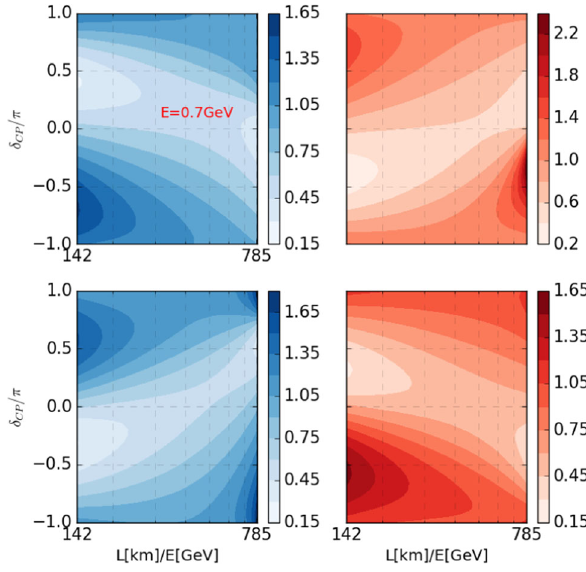
Fig. 3 Comparison between the unitary and non-unitary ν μ → ν e probabilities for φ 10 = π/ 2 ( − π/ 2) in the upper (lower) panel for the NO ν A experiment. Left (right) panel is for Normal hierarchy (inverted hierarchy). The unitary CP violating phase δ CP has been varied in its total range [− 180 ◦ : 180 ◦ ] . The non-unitary parameters are fixed at their boundary values in Eq. (18) taken from Ref. [46]